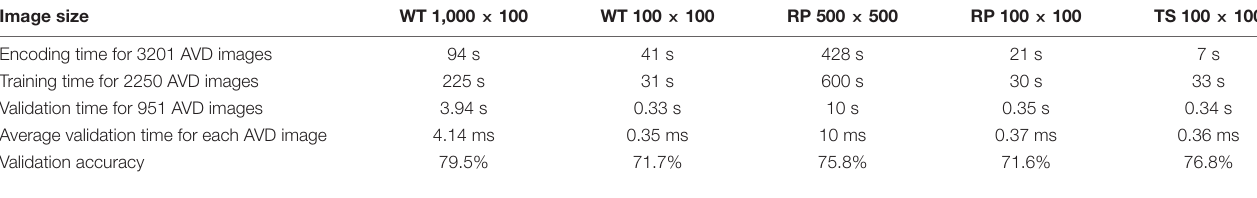
FIGURE 6 | Classification performance comparison of different models according to the F-measure of each damage class and overall accuracy. The overall accuracy (79.5%) of the CNN model trained with WT 1,000 × 100 AVD images is slightly higher than that (79.4%) of the IM-based machine learning LR model. TABLE 3 | Computational efficiency comparison of convolutional neural networks (CNN) models trained with different AVD images. Image